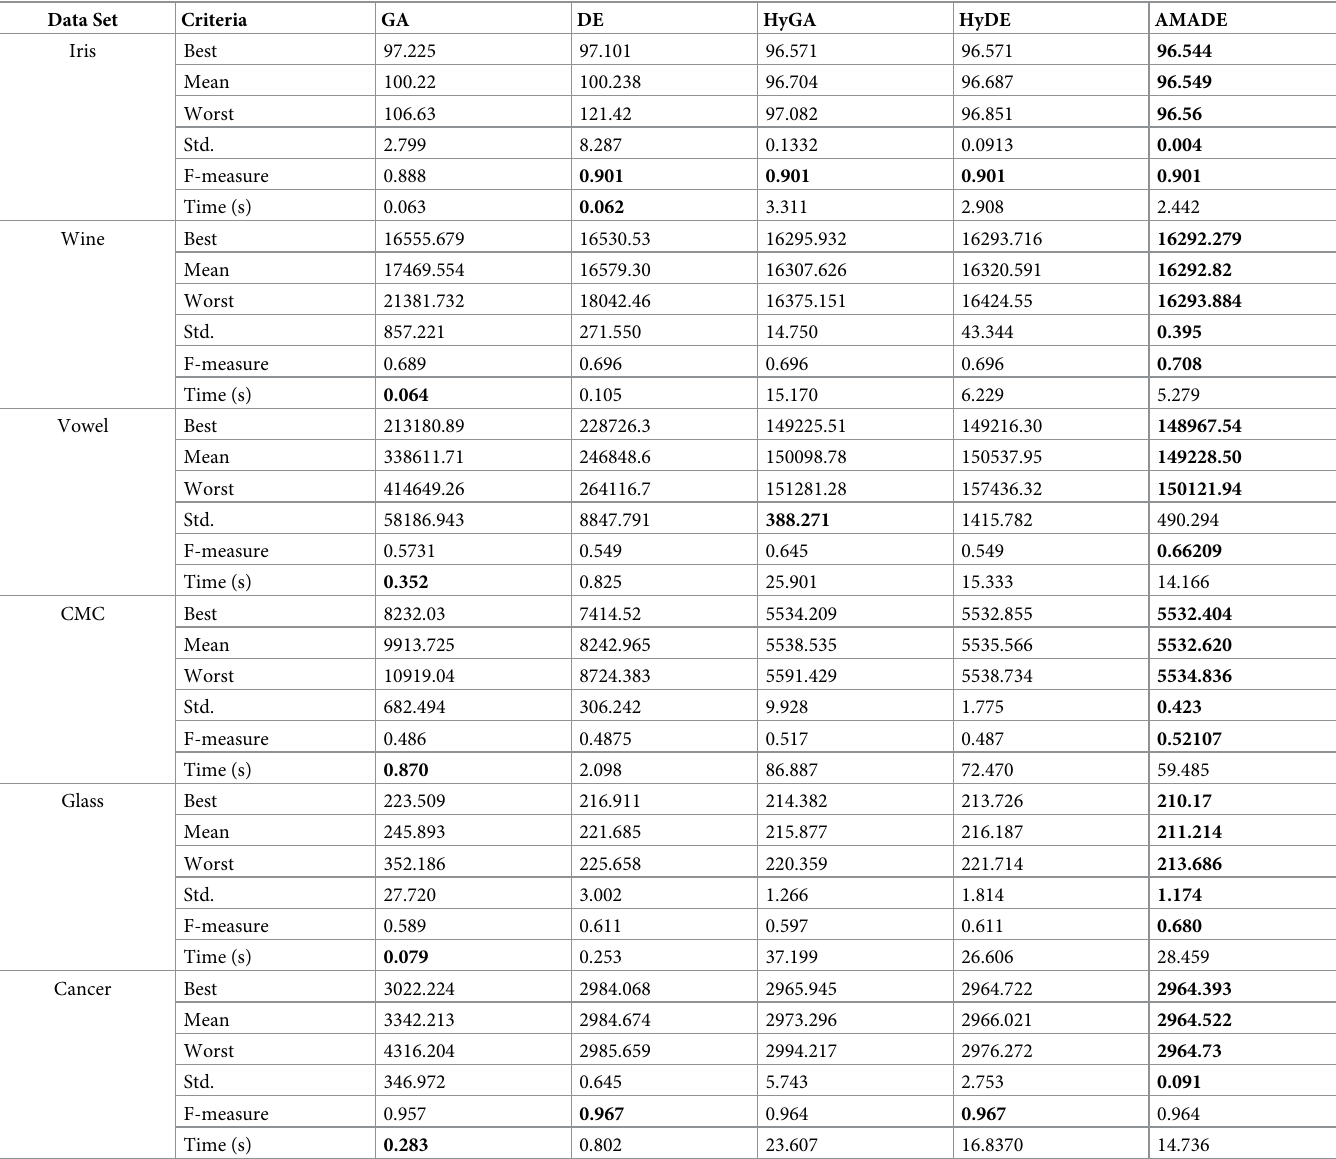
Table 3. Comparison of intra-clusters distances among AMADE, HyDE, HyGA, DE and GA obtained from 31 runs. Data Set